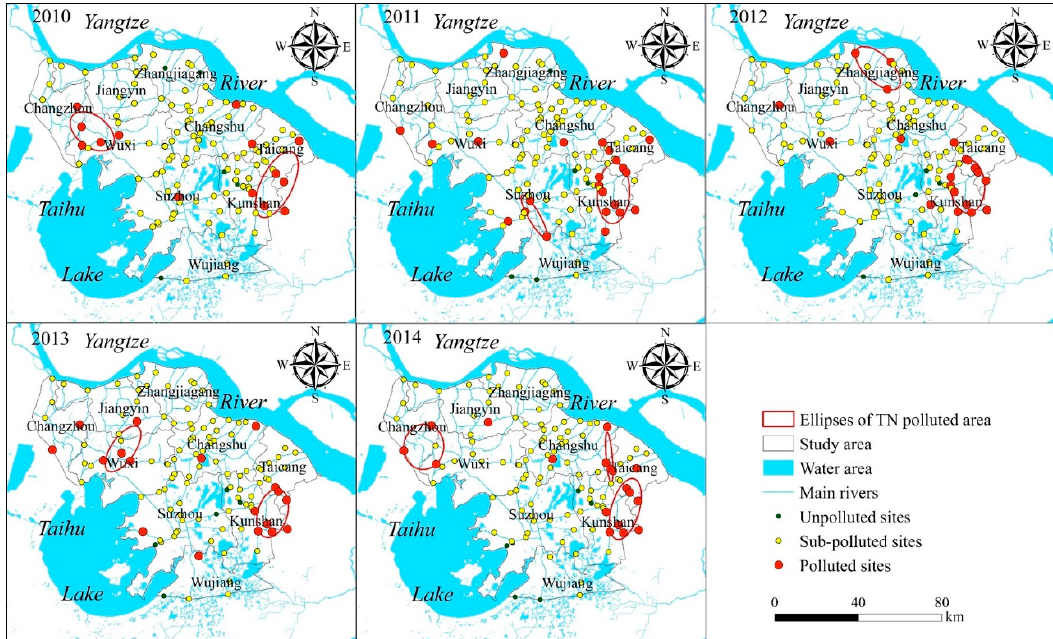
Figure 7. Standard ellipses of TN polluted regions from 2010 to 2014.